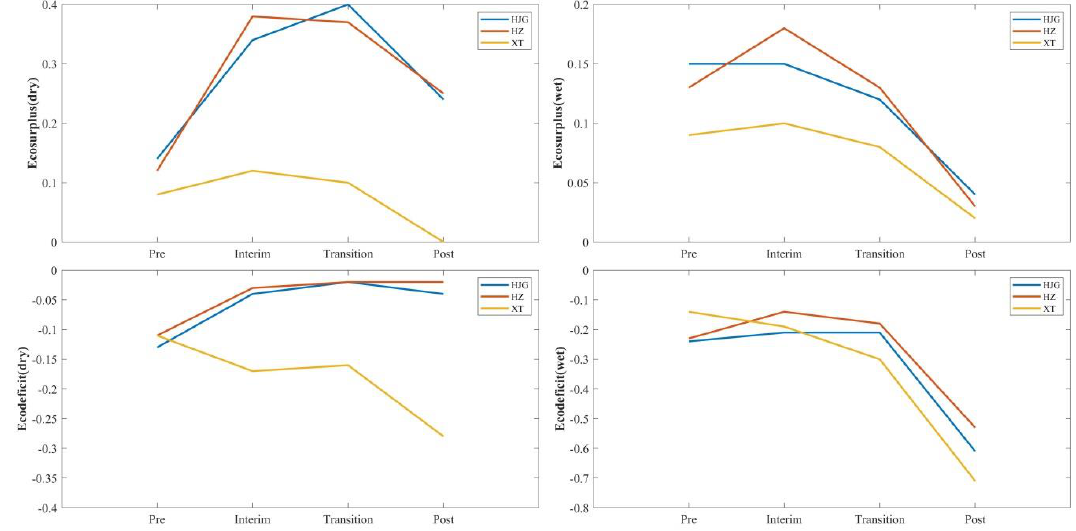
Figure 7. Mean values of seasonal ecosurplus and ecodeficit in the stations.